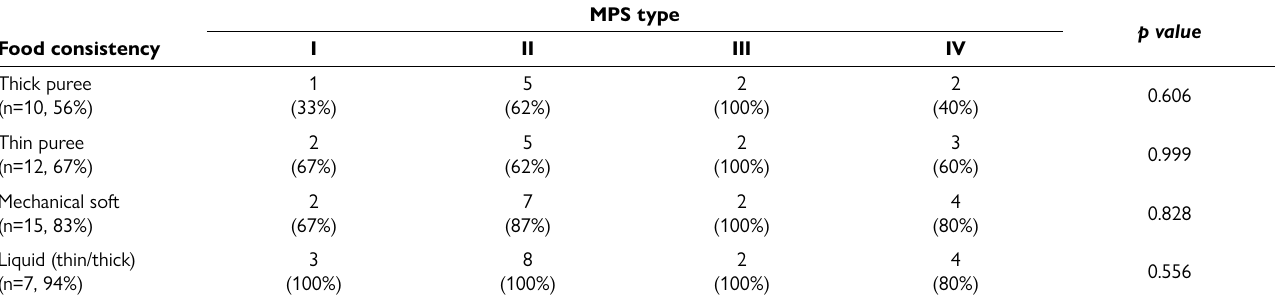
Table 2. Influence of the food consistency on the oropharyngeal dysphagia in patients with